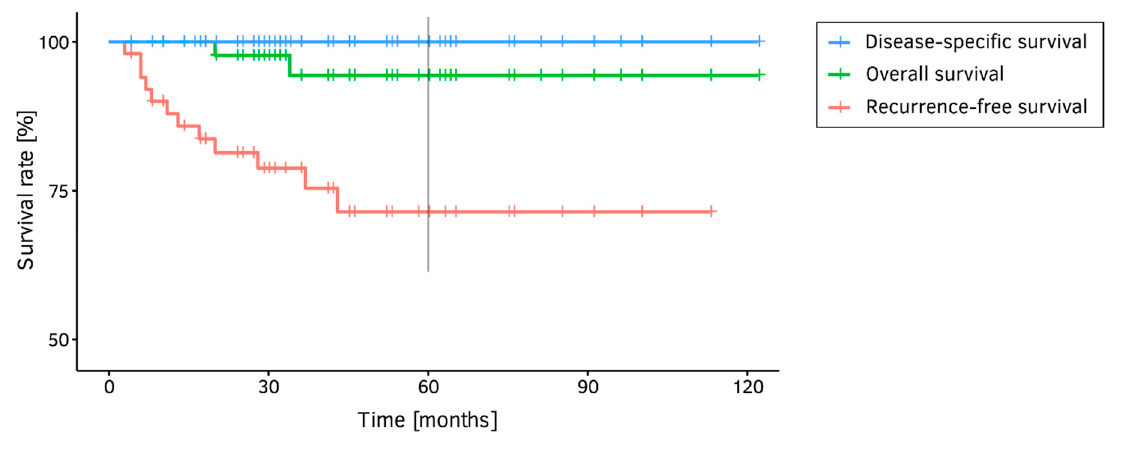
Figure 2. Five-year Kaplan–Meier estimates for recurrence-free survival, overall survival, and disease-specific survival.